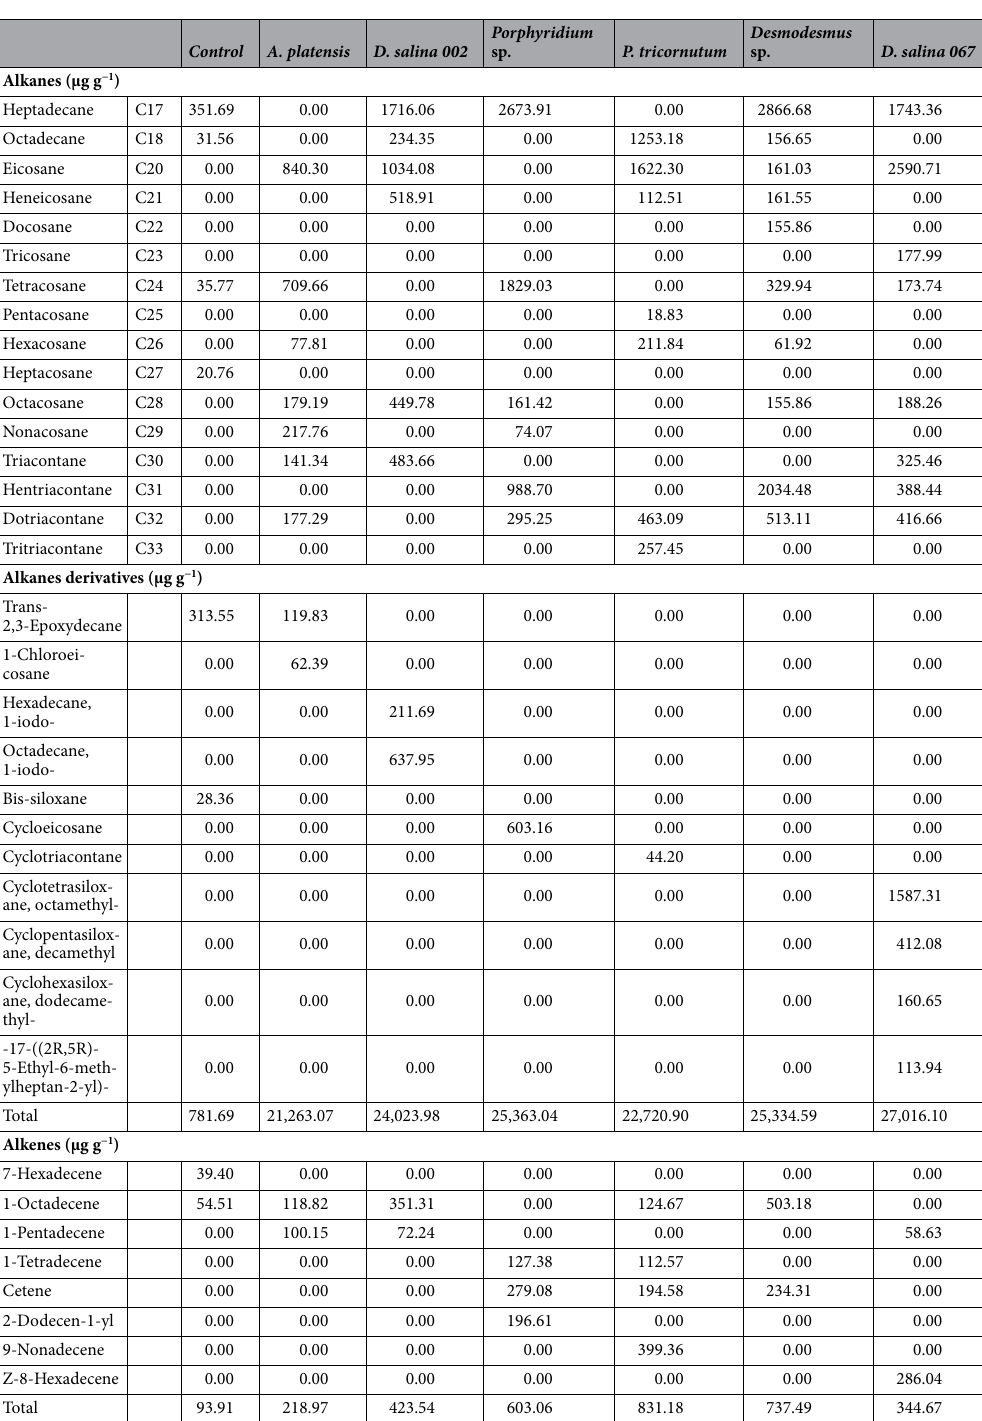
Table 3. The effect of microalgal polysaccharides on the biosynthesis and profile of alkanes and alkenes in tomato plants